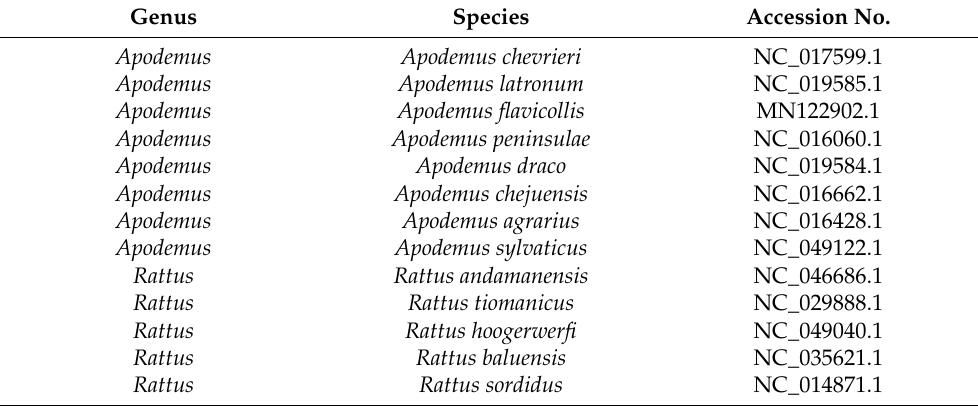
Table 1. Mitogenomes used in the